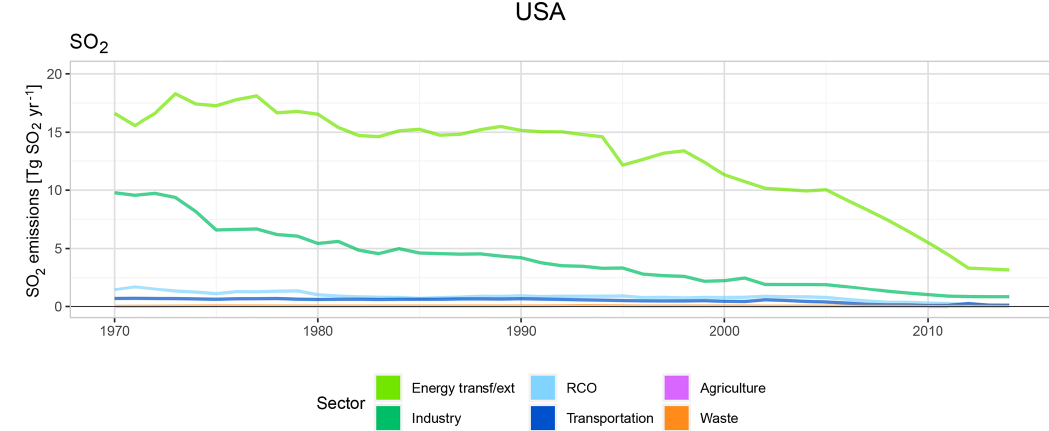
Figure 9. Time series plot for SO 2 by sector for the USA as a whole.